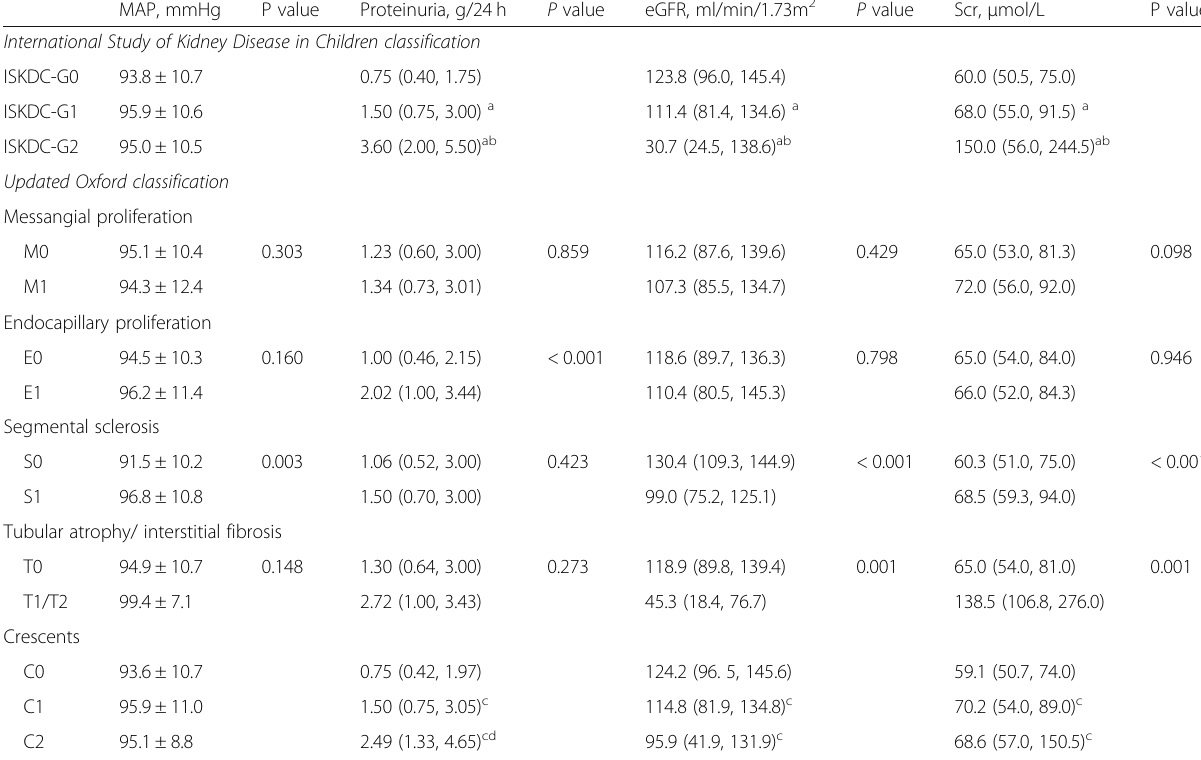
Table 4 Correlations between clinical data and pathologic classifications by the updated Oxford classification or the International Study of Kidney Disease in Children classification